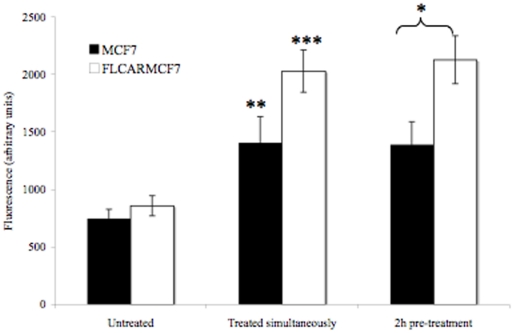
Ad5eGFP increases paracellular permeability.Paracellular permeability was assessed across MCF7 and FLCARMCF7 either basally and in response to Ad5eGFP (9000 VP/cell) added either simultaneously or 2 hours prior to incubation with FITC-dextran (1 mg/ml). No difference in basal permeability was seen between MCF7 and FLCARMCF7 cells. Incubation with Ad5eGFP led to increased permeability in MCF7 and FLCARMCF7 cells and this increase was more pronounced in FLCARMCF7 cells. *** = p<0.001, ** = p<0.01, * = p<0.05.